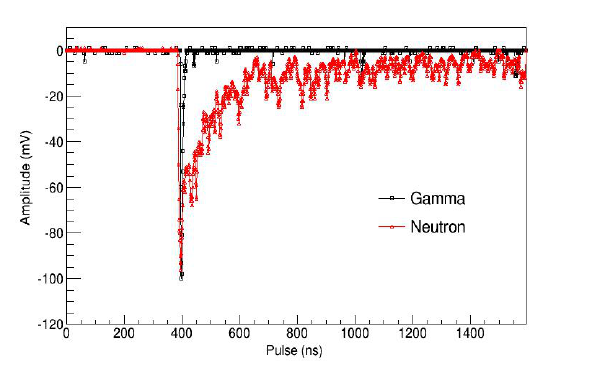
Fig.3 Neutron energy spectrum between 1.0 eV and 80.0 keV: energy spectrum of MFC (black solid line), energy spectrum of EJ-420 ( red dotted